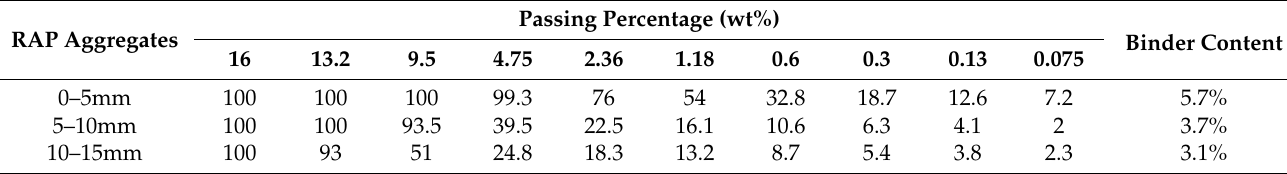
Table 6. The aggregate gradation and binder dosage in RAP